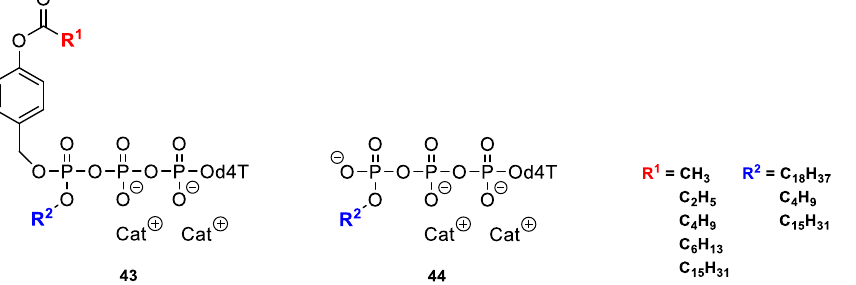
Figure 9. Structure of triphosphate pronucleotides 43 containing alkyl chains at the P γ moiety [120].